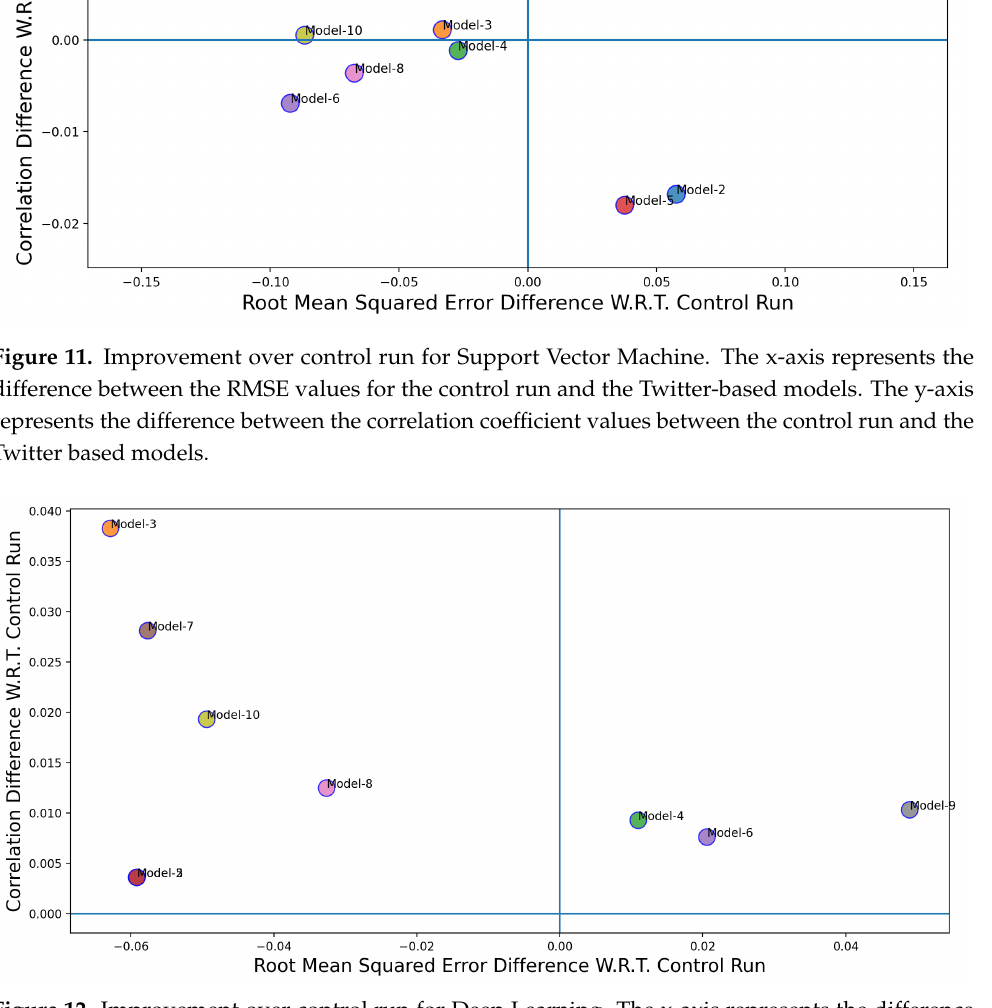
Figure 12. Improvement over control run for Deep Learning. The x-axis represents the difference between the RMSE values for the control run and the Twitter-based models. The y-axis represents the difference between the correlation coefficient values between the control run and the Twitter based